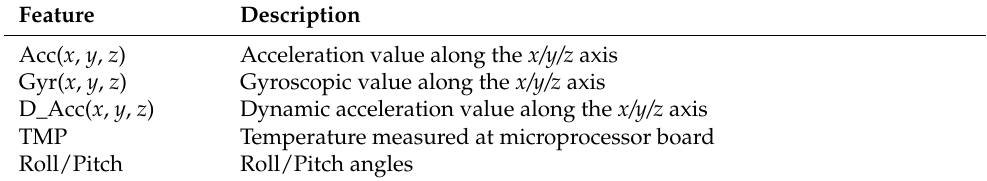
Table 2. Feature